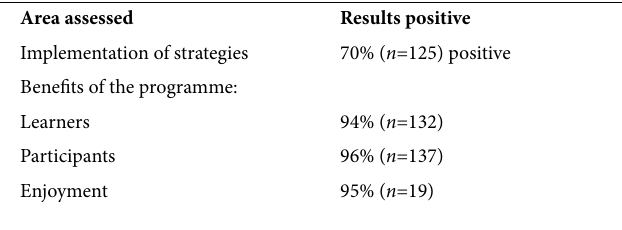
Table ii. Summary of the results obtained in the outcomes component Area assessed